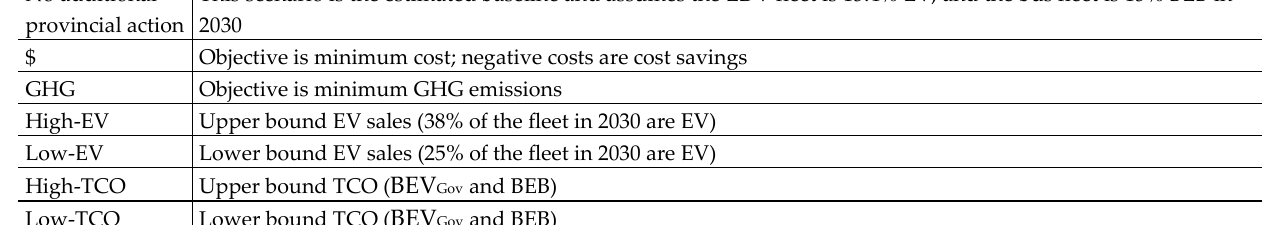
Figure 1. The provincial GHG emission reduction and cost boundaries of the MIO model. Green and yellow bars present results with provincial action in 2030. Blue bars represent no additional provincial action in 2030, the baseline conditions in 2020, and the 2005 values for comparison. These MIO model boundaries (yellow and green bars) demonstrate the realistic na- ture of conflicting objectives as well as contextualize the range of feasible solutions that exist within sets of the four Ontario policy solutions considered.